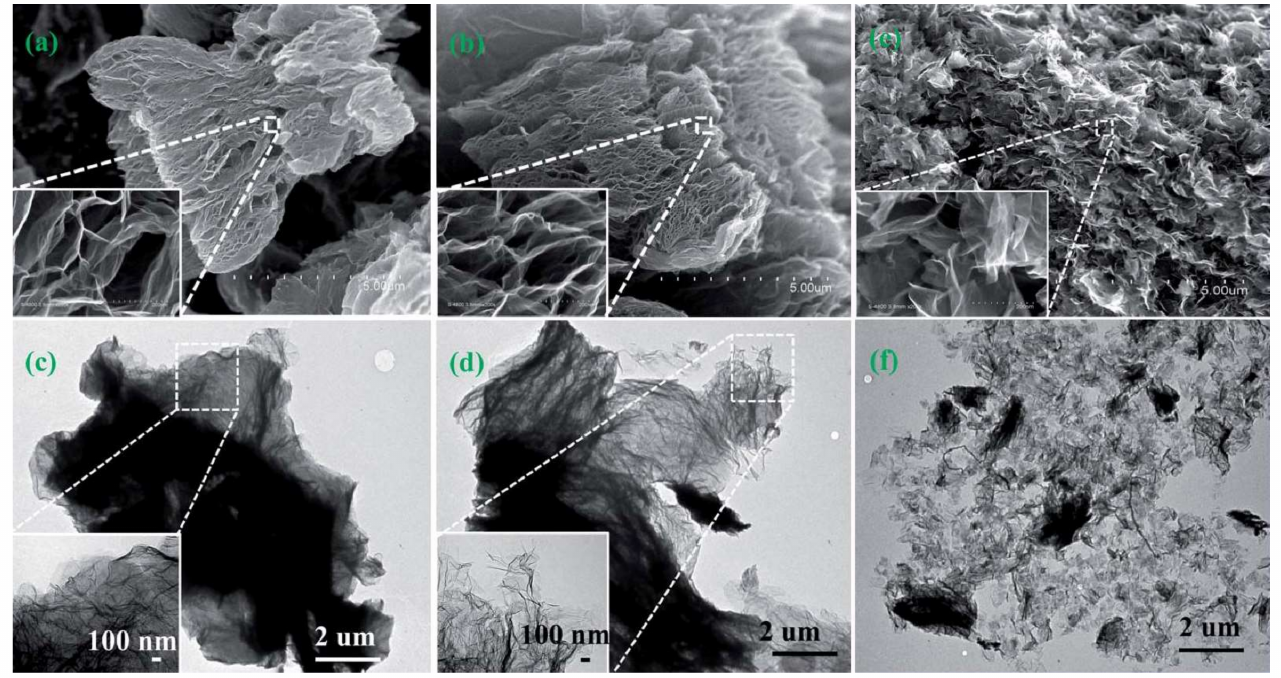
Figure 9. Morphological analysis of graphene nanosheets (GNS) synthesized in varying conditions; SEM images of ( a ) GNS-I, ( b ) GNS-II, and I GNS-III; TEM images of ( c ) GNS-I, ( d ) GNS-II,( e ) SEM image of GNS-III; TEM image of GNS-II and ( f ) GNS-III. Adapted and reproduced with permission from Ref. [35]. Copyright 2013 Royal Society of